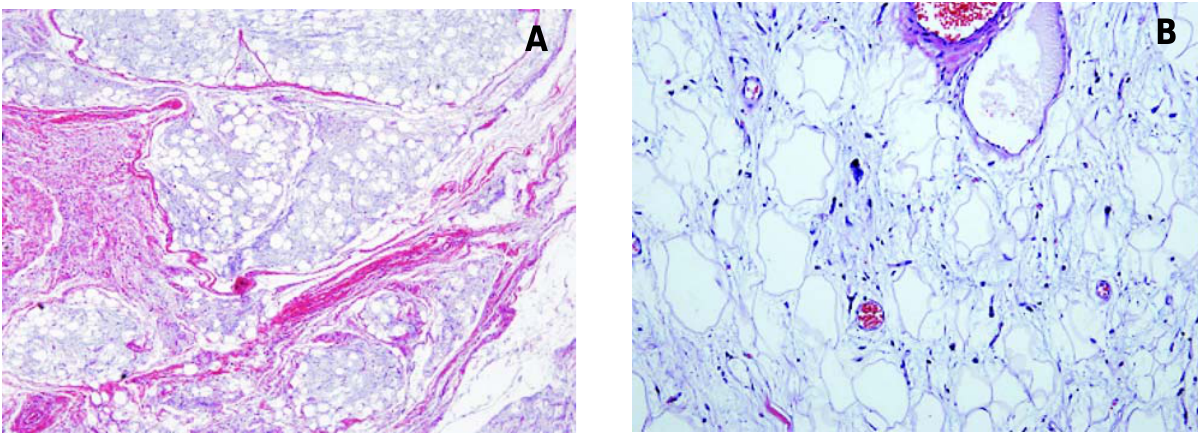
Figure 2 – Pathological findings of the tumor are indicative of myxoid liposarcoma. A) Paratesticular liposarcoma (HE, X40). B ) Pelvic liposarcoma (HE,